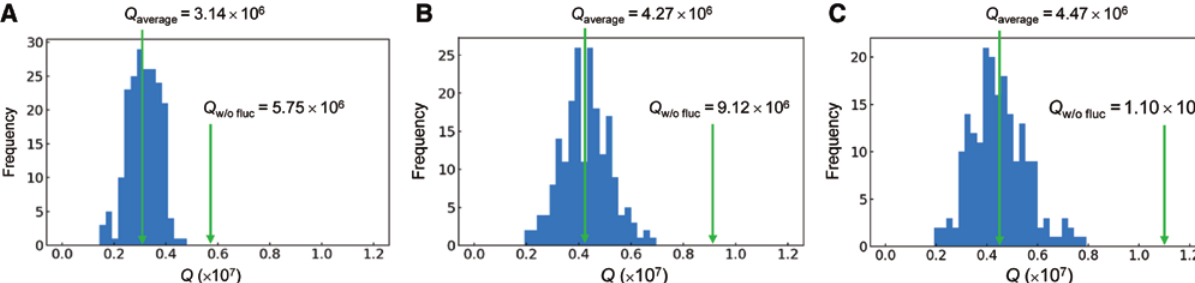
Figure 10: The influences of random fluctuations of air hole radii and positions on the Q factors. The results for the cavity designs optimized by the strategies A, A + B, and A + C are shown in (A), (B), and (C), respectively. The random deviations follow a Gaussian distribution with a standard deviation of a /1000, and the same 200 random deviation patterns are applied to the cavities optimized by the three different